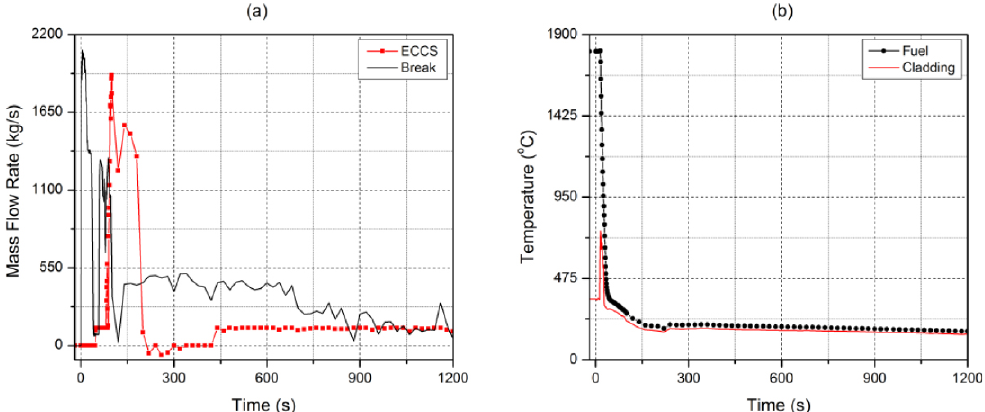
Fig. 8. Total mass fl ow rate injected and removed from RCS (a). Fuel and cladding temperature at level 18 of HS-605